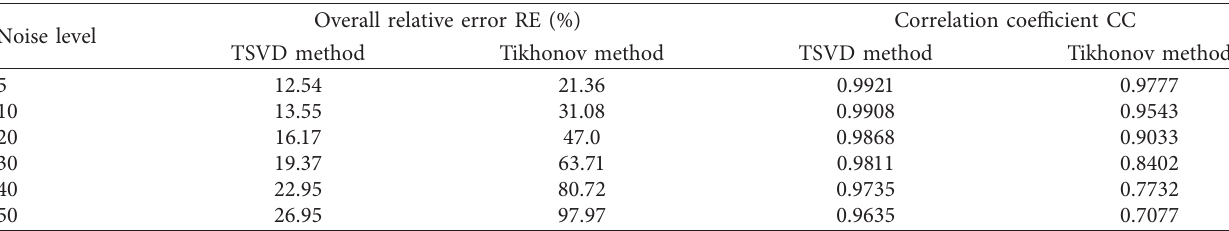
Table 1: Identification error at different noise